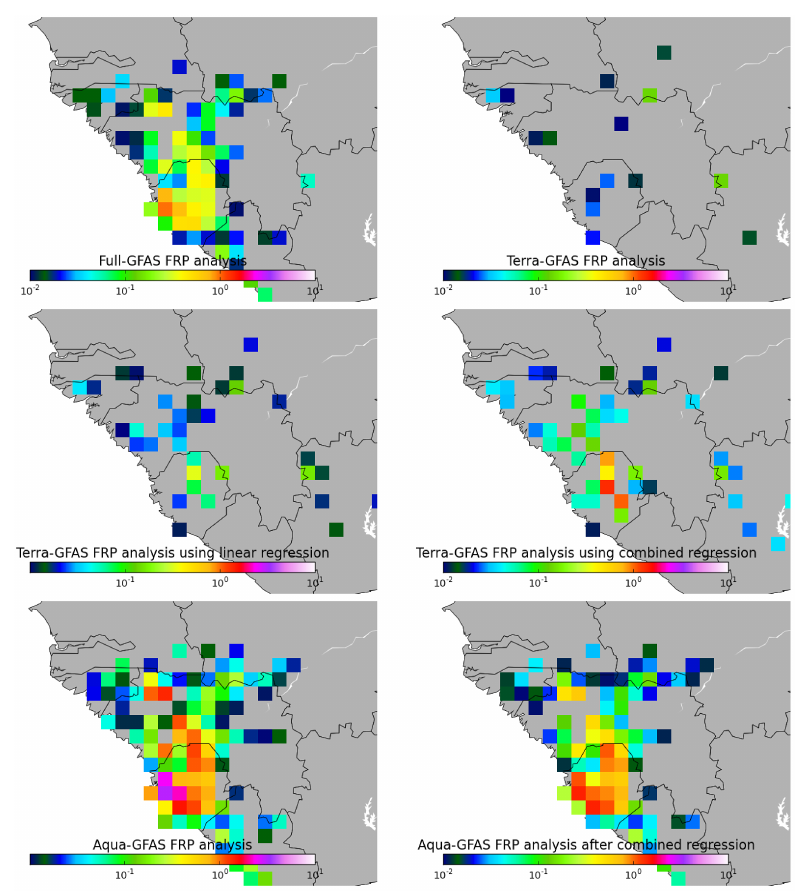
Figure 9. Daily FRP in mWm 2 for West Africa on 03/04/2012, given by Full-GFAS (top left), Terra-GFAS (top right), Terra-GFAS using linear regression (middle left) and non-linear regression (middle right), as well as Aqua-GFAS (bottom left) and Aqua-GFAS using non-linear regression (bottom